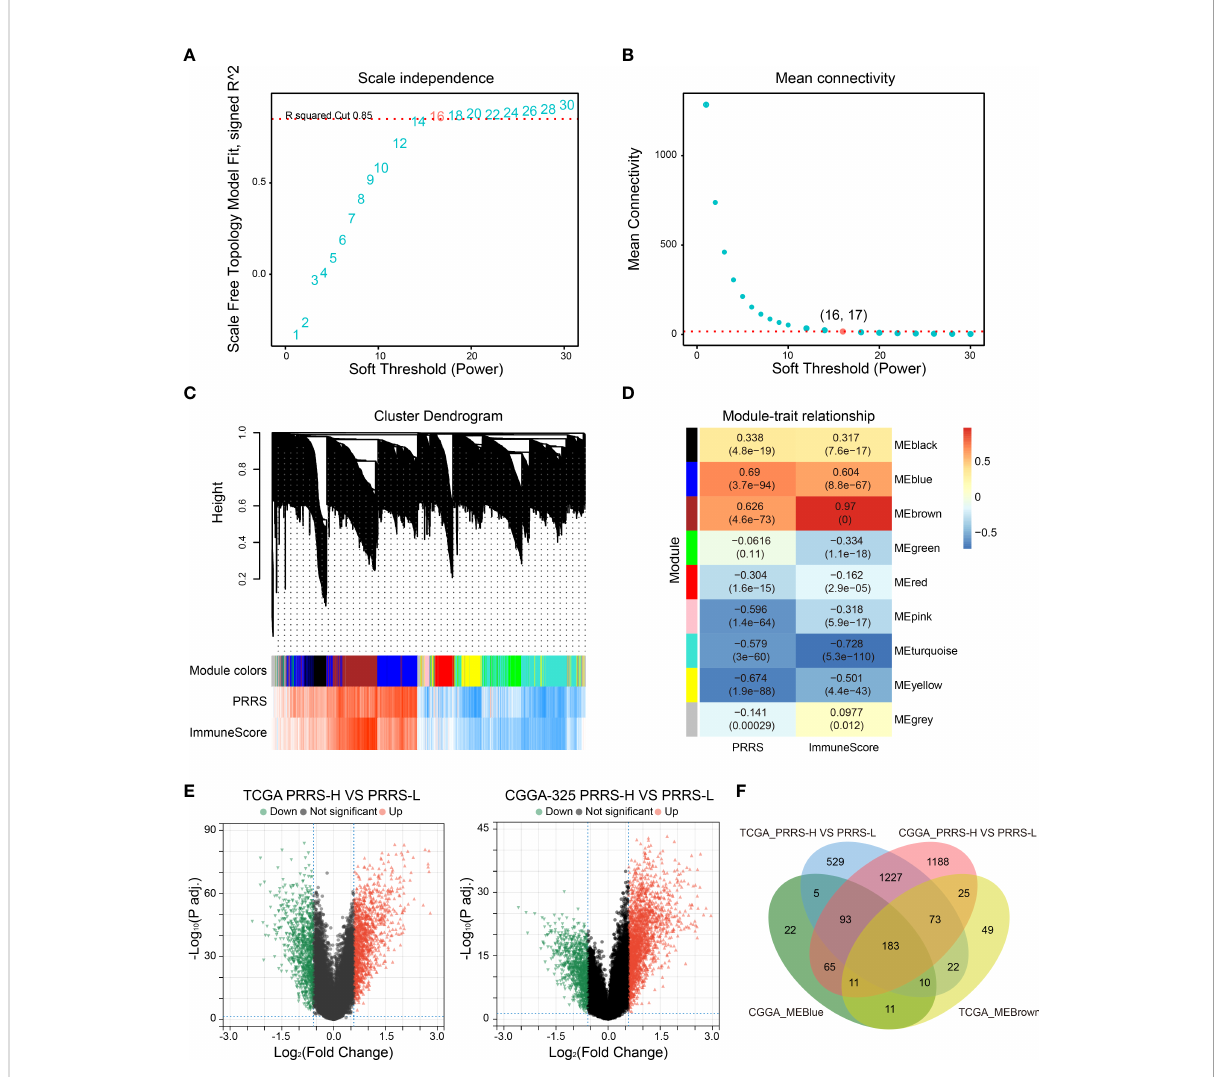
FIGURE 9 Identi fi cation of canonical module genes related with PRRS by weighted gene co-expression network analysis (WGCNA). (A, B) Determination of soft-threshold power in WGCNA. The most appropriate power was 16 (A) , and the corresponding number of mean connectivity was 17 (B) . (C) Cluster dendrogram and module assignment in WGCNA. (D) Association between module and PRRS and ImmuneScore through module – trait relationship analysis. (E) Differentially expressed genes (DEGs) were analyzed between high- and low-PRRS groups in TCGA and CGGA cohort, respectively. (F) Venn diagram showing the overlap between module genes and